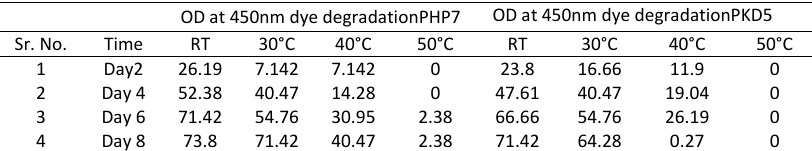
Table 8: Laccase enzyme activity of PHP7 U/L and PKD5 U/L at different temperature Table 8. Laccase enzyme activity of PHP7 U/L and PKD5 U/L at different Sr. No. Temp.